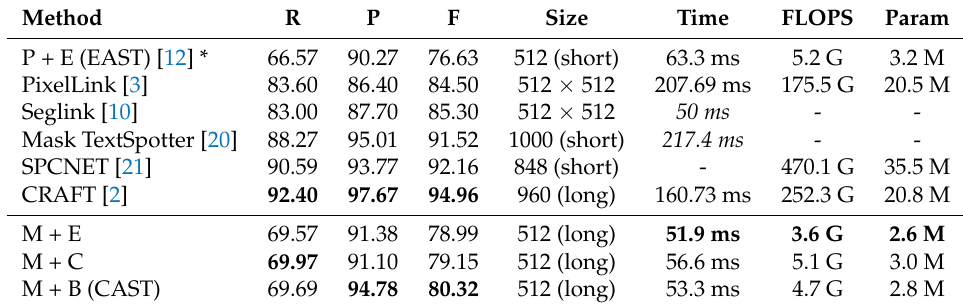
Table 1. Results with the ICDAR2013 dataset, where R , P , and F represent the recall, precision, and F1 score, respectively. An asterisk(*) indicates that the corresponding result is obtained in our own experiments. M and P denote MobilNetV2 and Pvanet, respectively. E, C, and B are the EAST decoder, the CRAFTdecoder, and our proposed balanced decoder, respectively. The inference time represents the time needed for obtaining a result for an image, where italic values indicate that the values are borrowed from other studies.